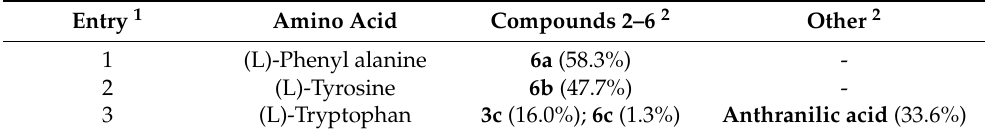
Table 6. Biotransformation of (L)-phenylalanine, (L)-tyrosine and (L)-tryptophan using Yarrowia lipolytica (DSM